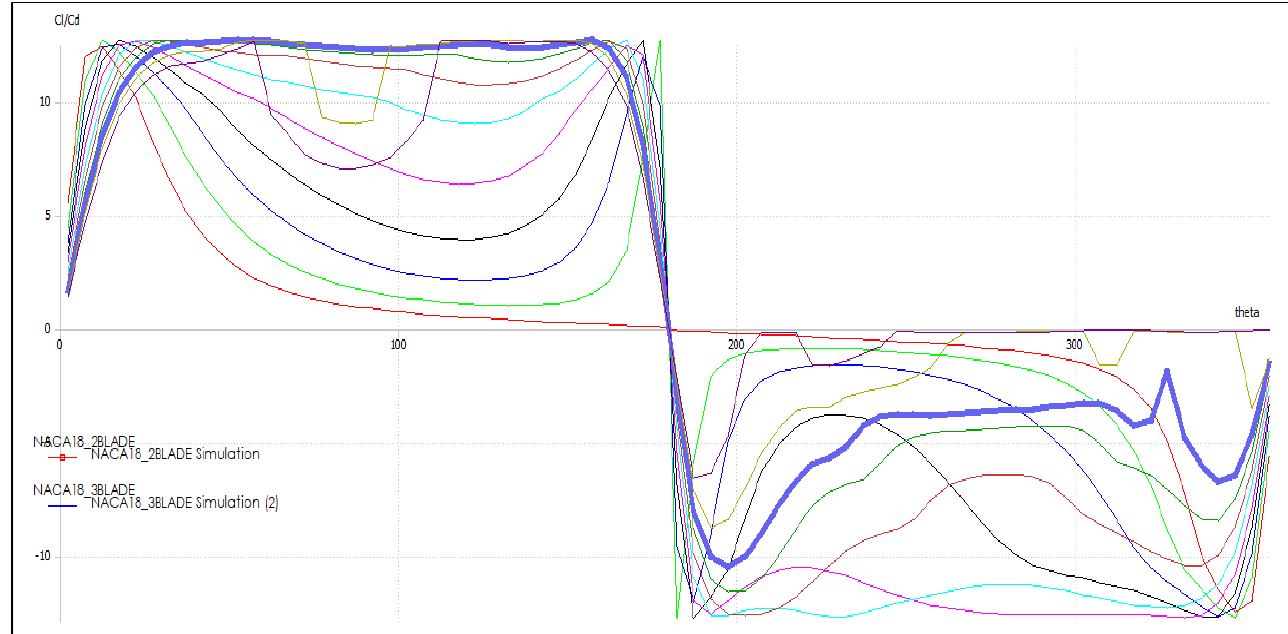
Figure 36. Cl/Cd vs theta plot of mid-section for TSR